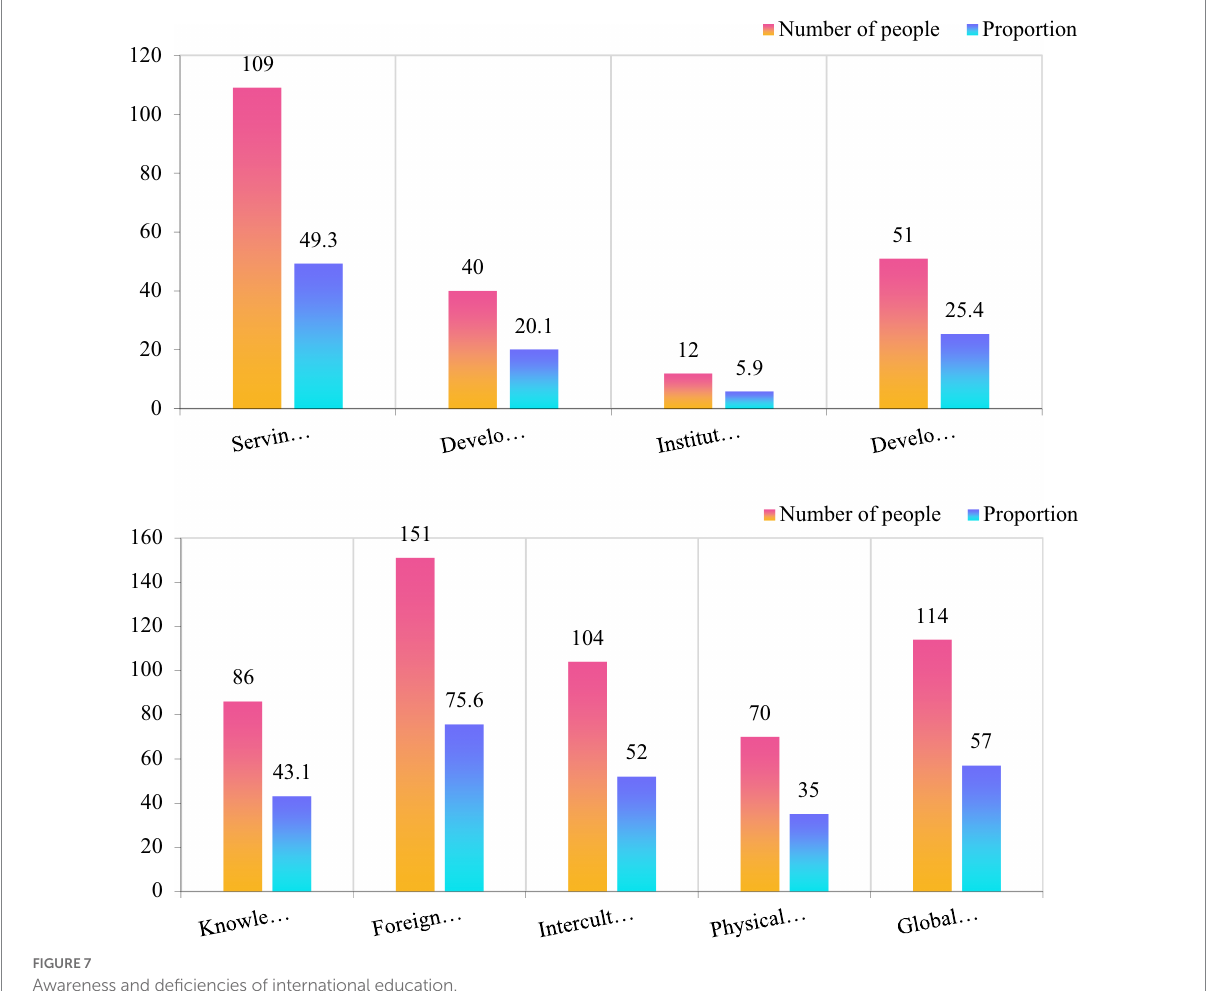
FIGURE 7 Awareness and deficiencies of international